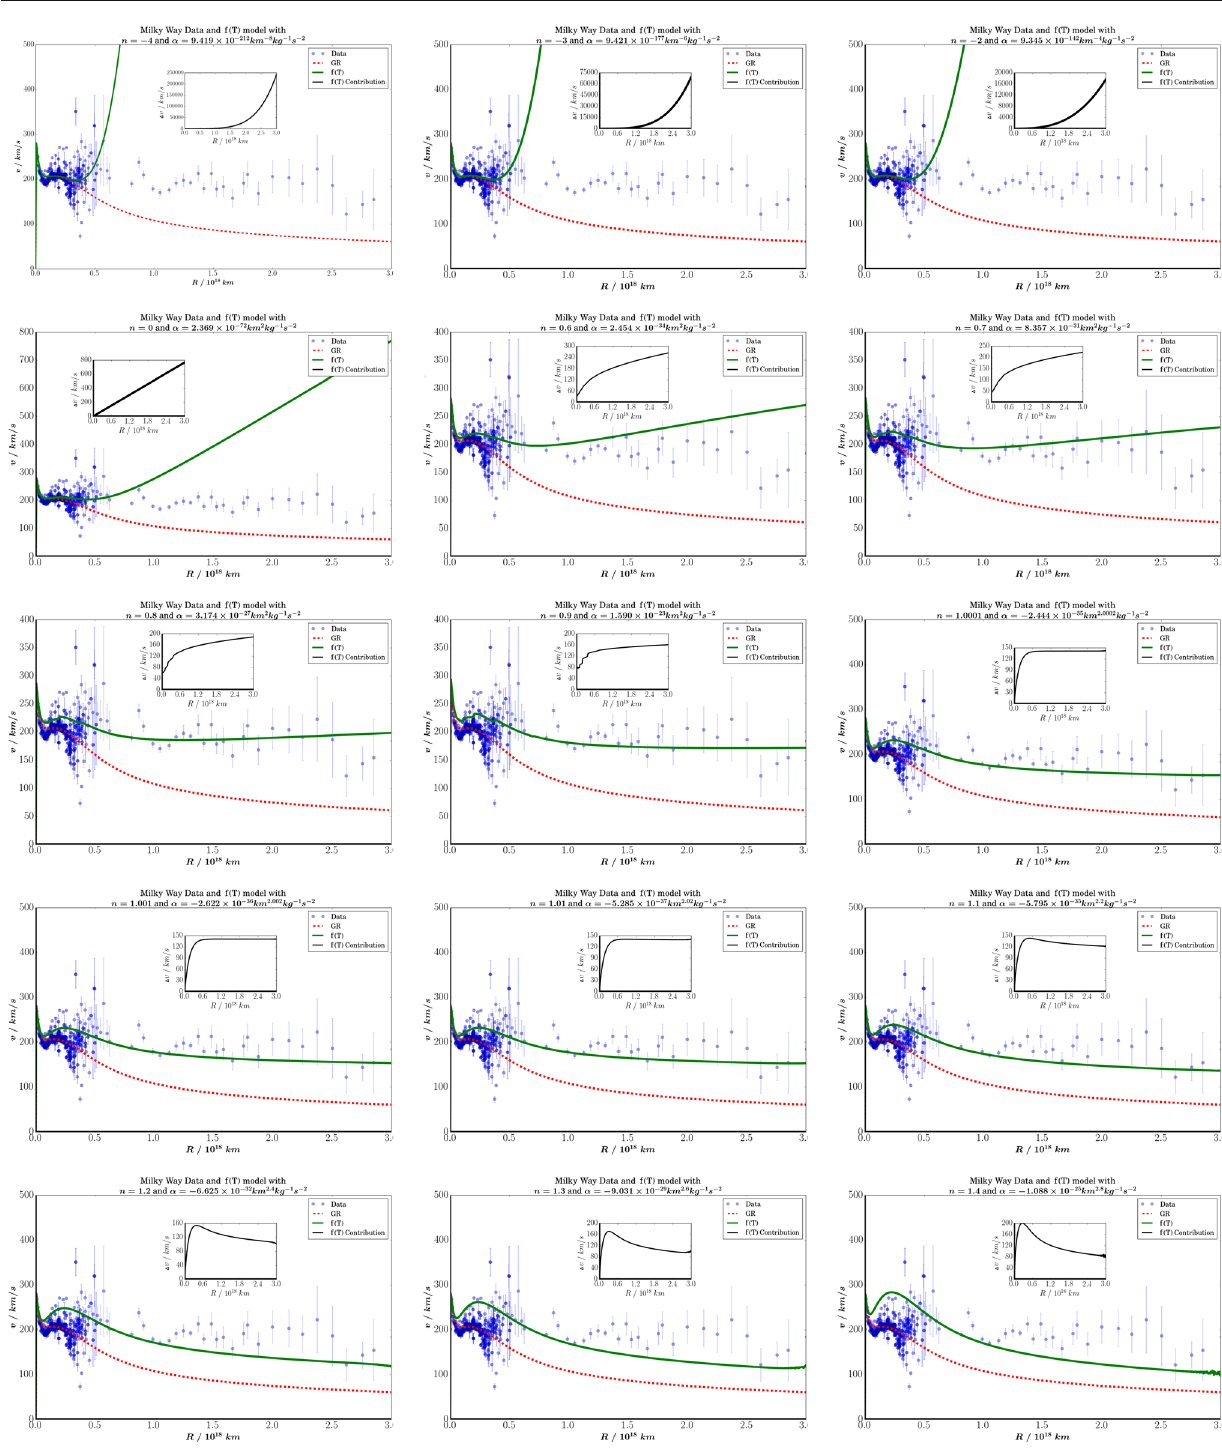
Fig. 2 f ( T ) gravity rotational velocities with n values from − 4 . 0 to 1 . 4. The coupling constant for each graph was obtained through fitting as governed by Eq. (47). The data points are rotational velocity values obtained from a combination of two data sets, namely Refs. [30,32].